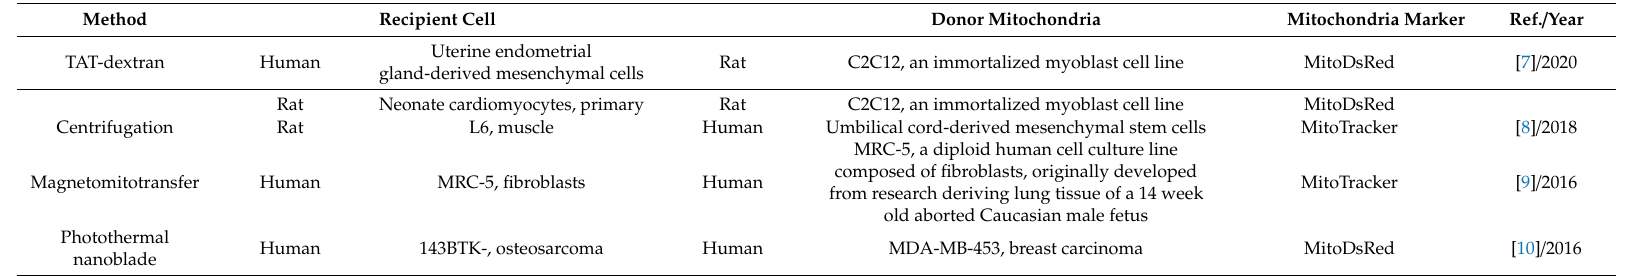
Table 2. Current reported technologies used to enhance mitochondrial transfer in